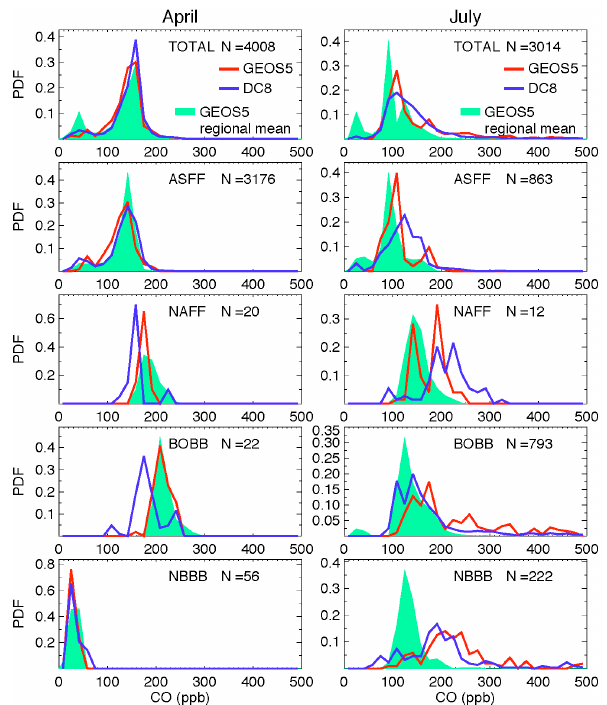
Figure 9: The probability distribution function (PDF) of total CO over two ARCTAS campaign periods and over the 4 tagged CO categories. Please note EUFF is not shown since CO from European anthropogenic emissions seldom dominated the Arctic CO during the campaign. The green areas are the PDFs of GEOS-­‐5 CO over the Arctic region 50N-­‐90N and 190E-­‐320E and up to 200 hPa. The blue and red lines are the PDFs of DC-­‐8 and GEOS-­‐5 sampled along flight tracks and N is number of 1-­‐minute data point.